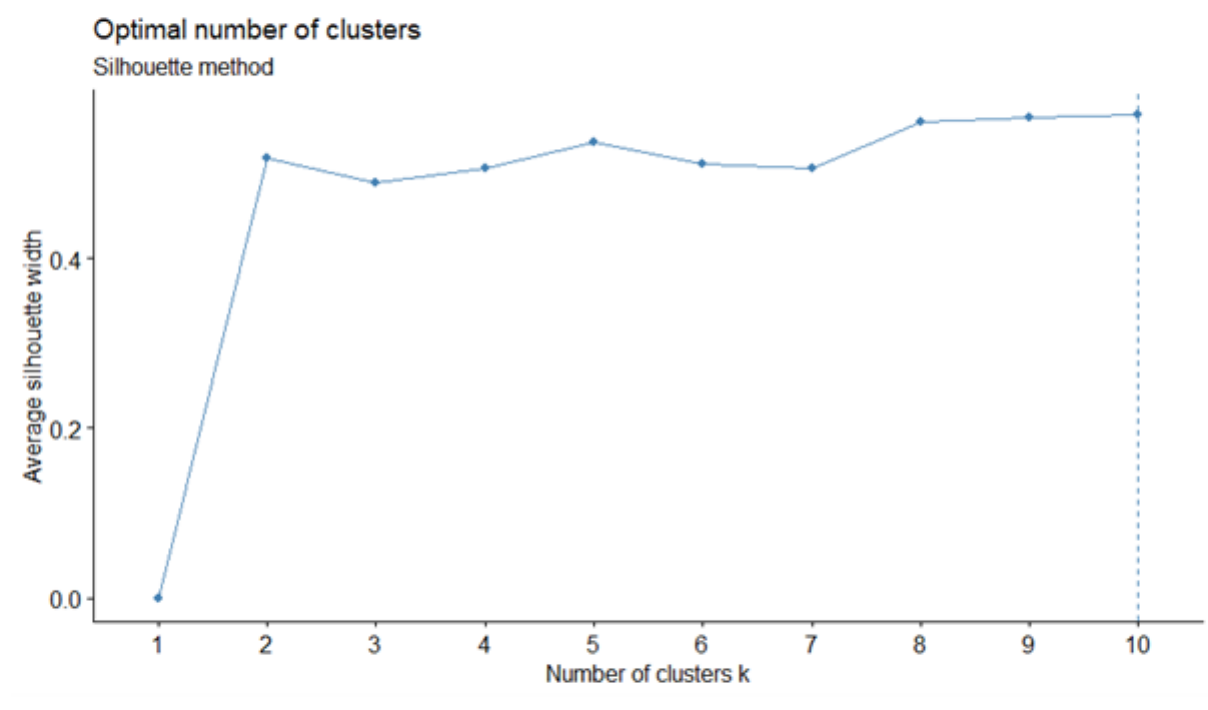
Figure 7. Silhouette statistics for the sub-cluster of capacities for the activities of daily